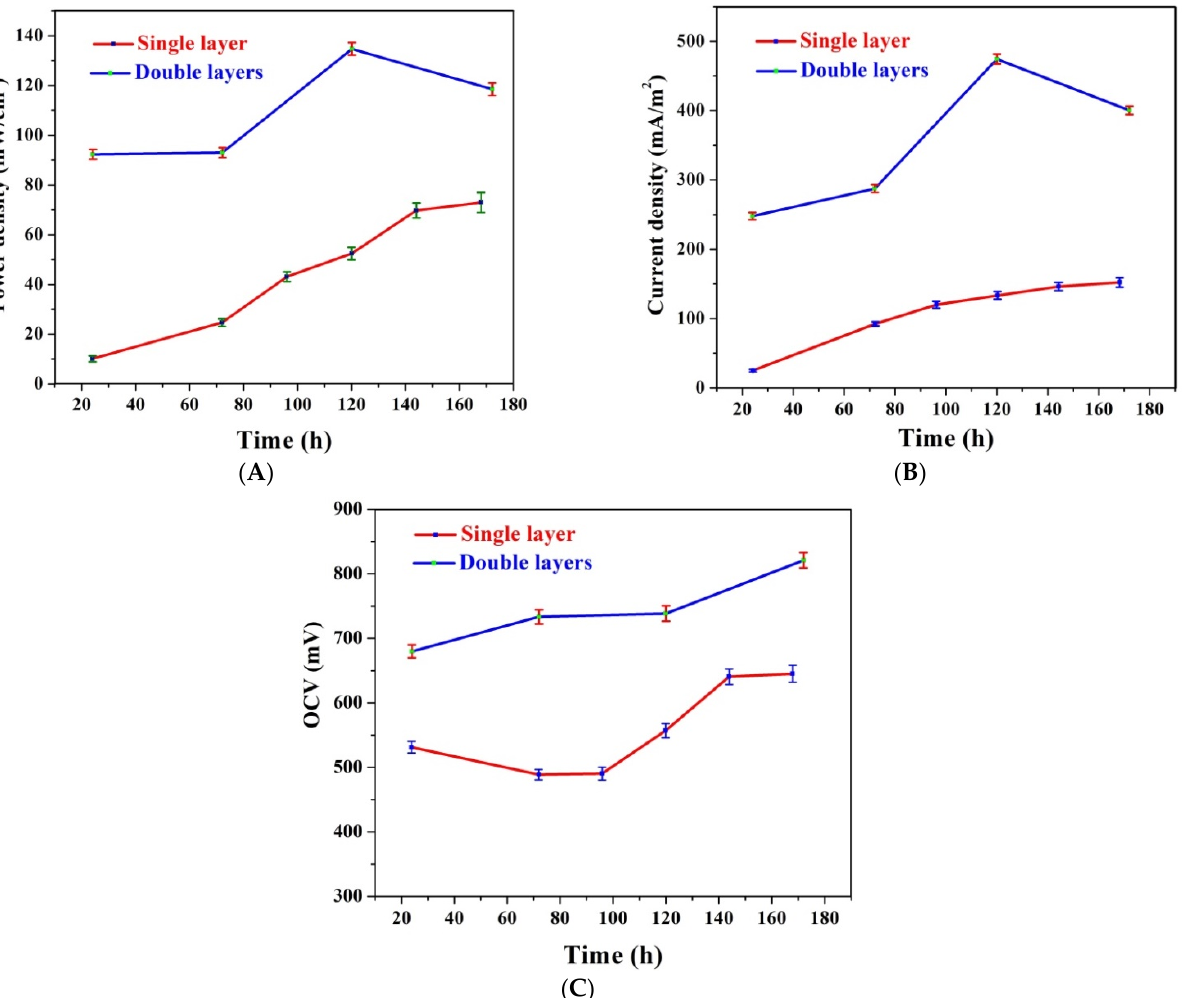
Figure 7. Influence of utilizing double layer carbon nanofibers as anodes on the obtained power density ( A ); current density ( B ); and open circuit potential ( C ).